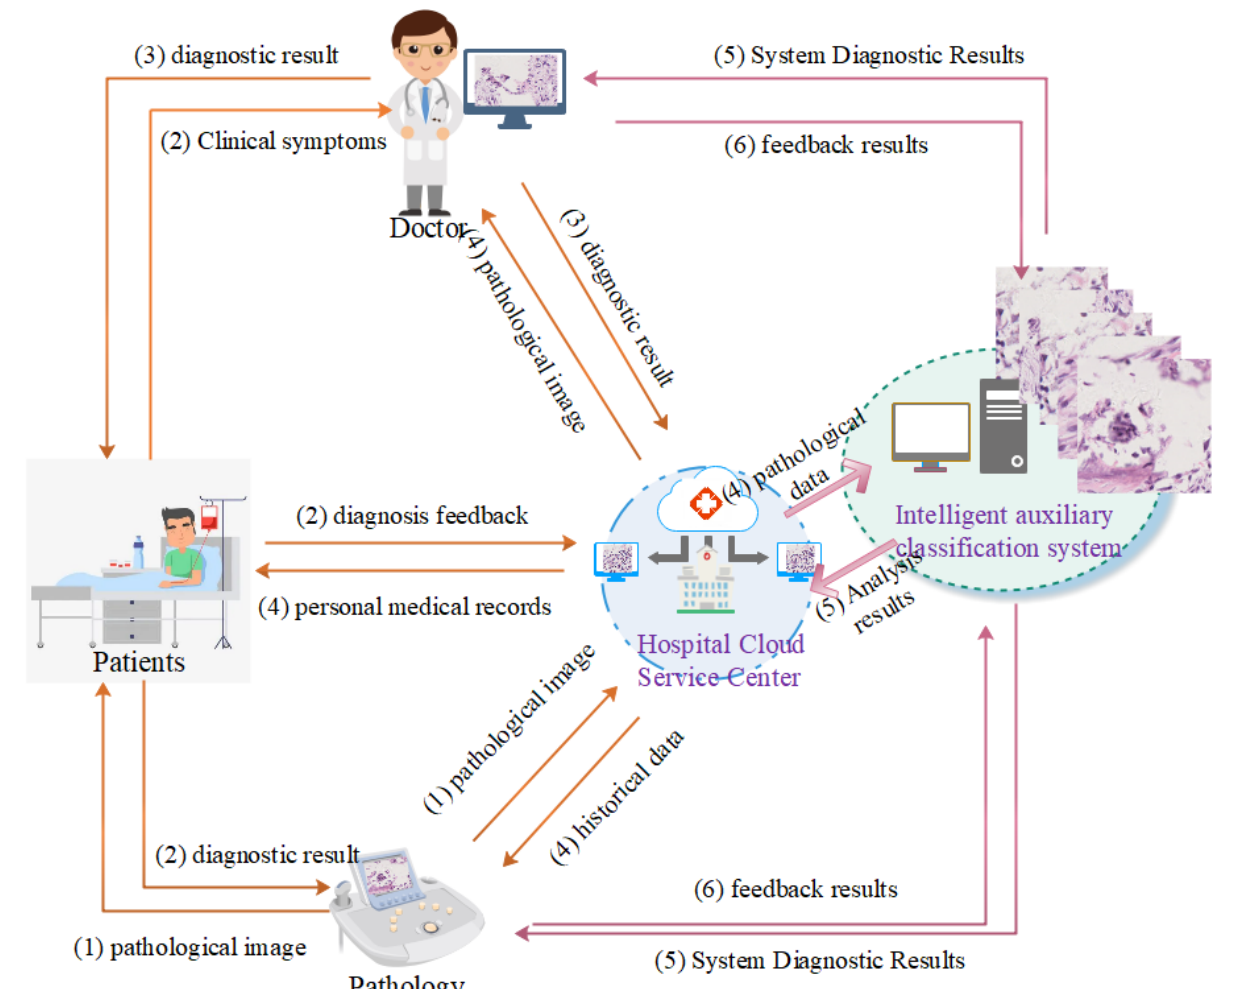
Figure 1. Patient pathology data decision-making process. The orange arrow is the workflow of the original medical system. The purple arrow is the workflow after adding the intelligent classification assistance system.